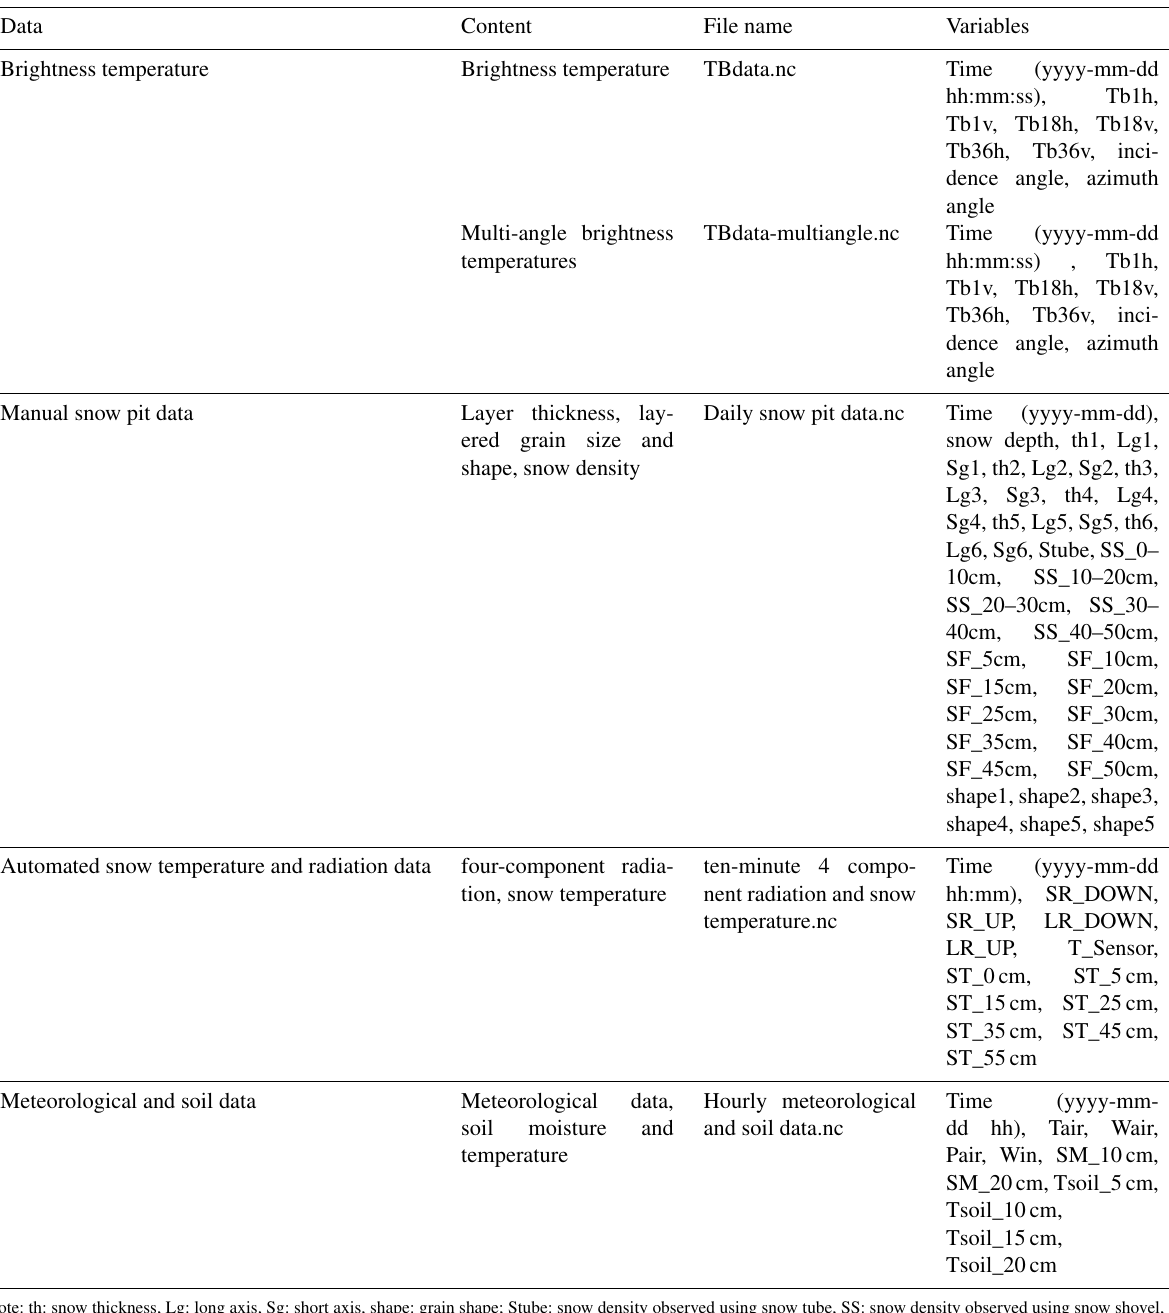
Table 5. Description of consolidated